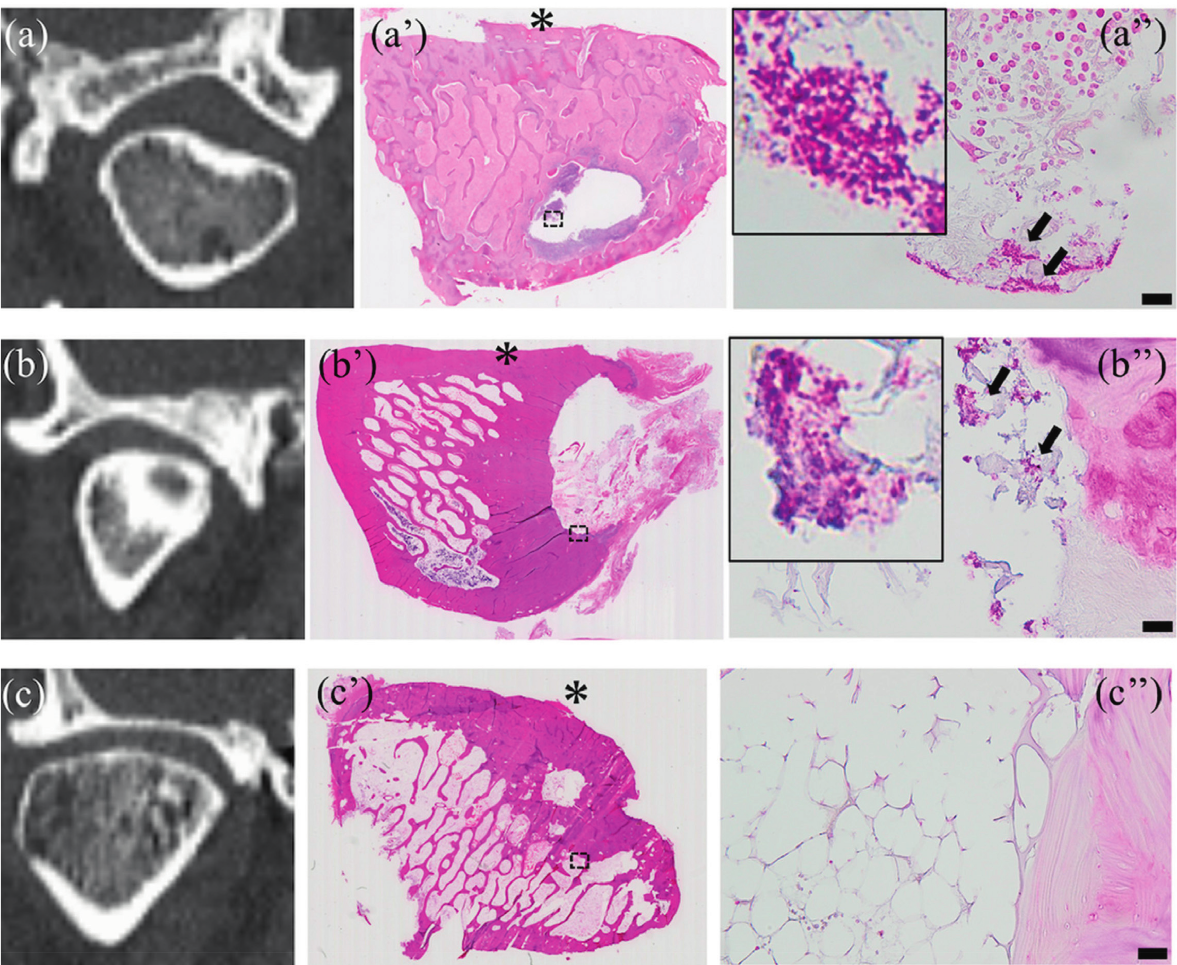
Figure 3: Preoperative CTimages of condyles (a–c) and results of hematoxylin and eosin staining (a’–c’) in mandibular condyles of patients 1, 2, and 4. Results of Gram staining of areas indicated with black dotted boxes are shown in enlarged images (a”–c”). Within the region of partial bone marrow hollowing, inflammatory cell infiltration (a’) and bacterial colonization (a”) are evident in condyle of patient 1. Within the region of cortical hollowing, chronic fibrosis (b) and bacterial colonization (b”) are evident near condyle of patient 2. Although fibrosis and fatty degeneration are evident in bone marrow area (c’), no bacterial colonization is evident (c”) in condyle of patient 4. Asterisks ( ∗ ) indicate the articular surfaces of condyles. Scale bar � 20 μ